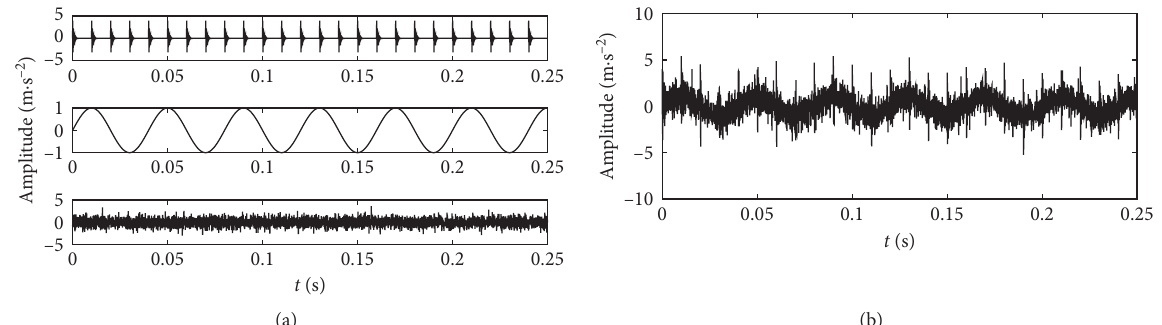
Figure 2: Time-domain diagram of (a) components of simulation signal and (b) combined simulation signal.